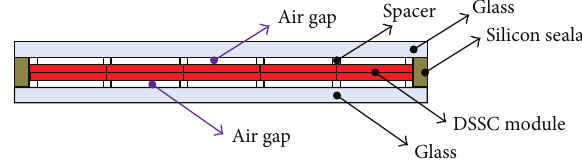
Figure 1: Triple glazing unit type DSSC